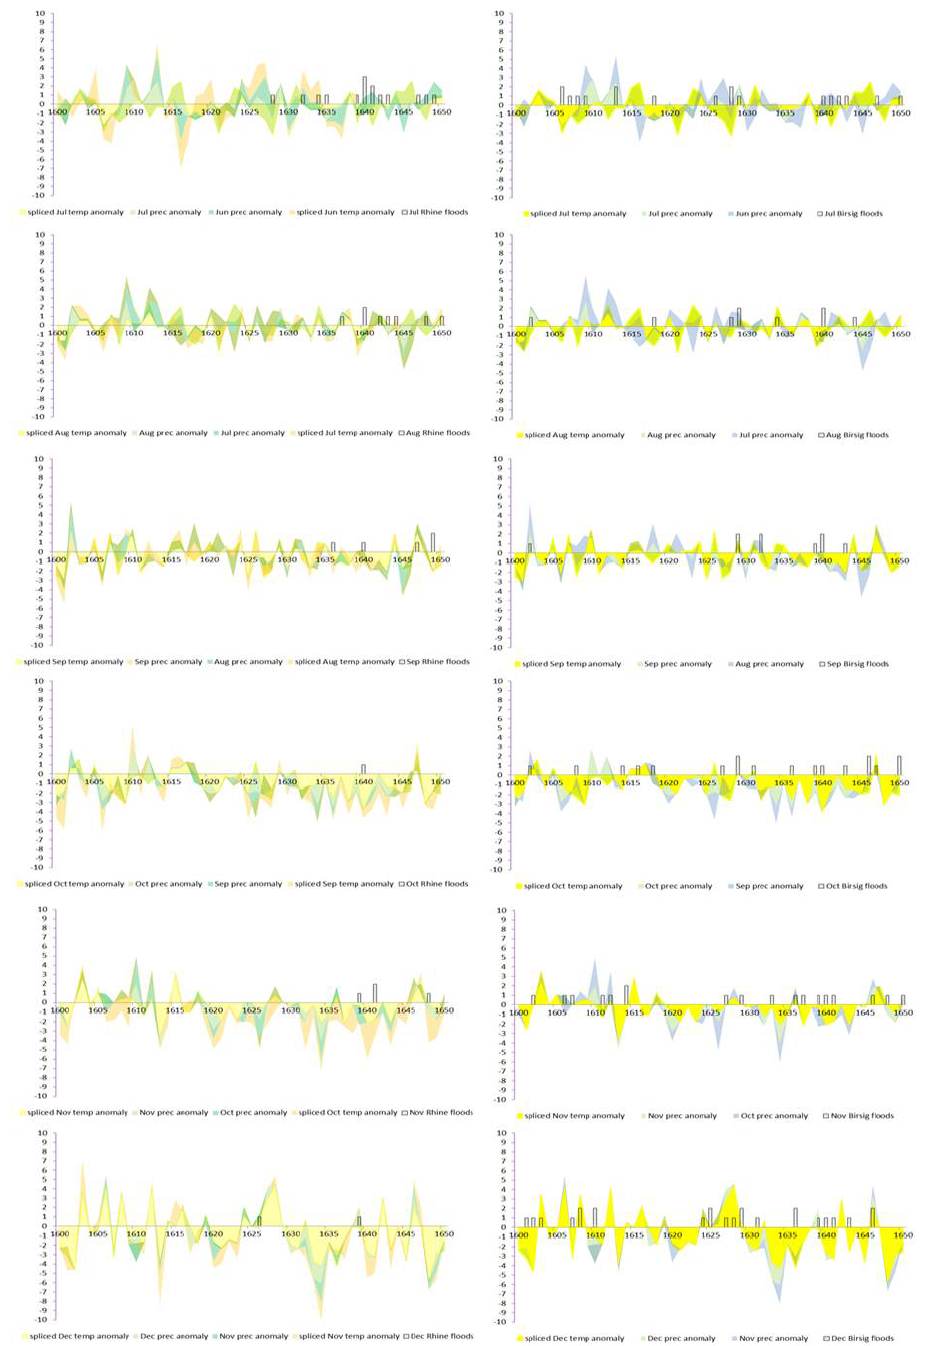
Figure 20. Monthly spliced temperature (Dobrovolný et al., 2009) and precipitation (Pfister, 1999) reconstructions combined with Rhine and Birsig River flood proxies from the weekly books of expenditures from the city of Basel – July to